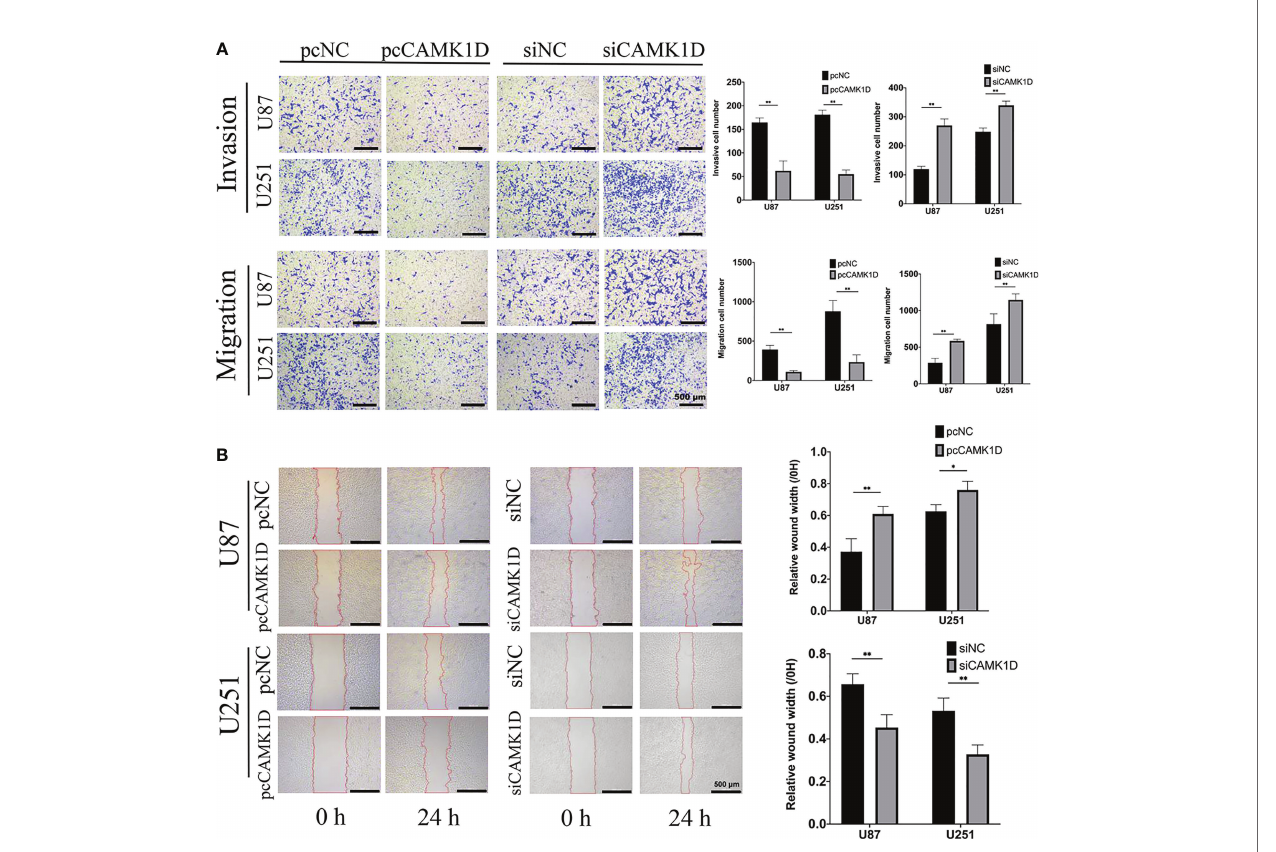
FIGURE 5 | CAMK1D inhibits the invasion and migration of glioma cells. (A) Transwell assays revealed that CAMK1D overexpression reduced the invasion and migration of U87 and U251 glioma cells. The invasive cell numbers and migration cell numbers of U87 and U251 cell lines were signi fi cantly decreased by overexpression of CAMK1D with pcCAMK1D. (B) Wound healing assay showed that overexpression of CAMK1D reduced the relative wound width in U87 and U251 glioma cells. * p < 0.05; ** p <